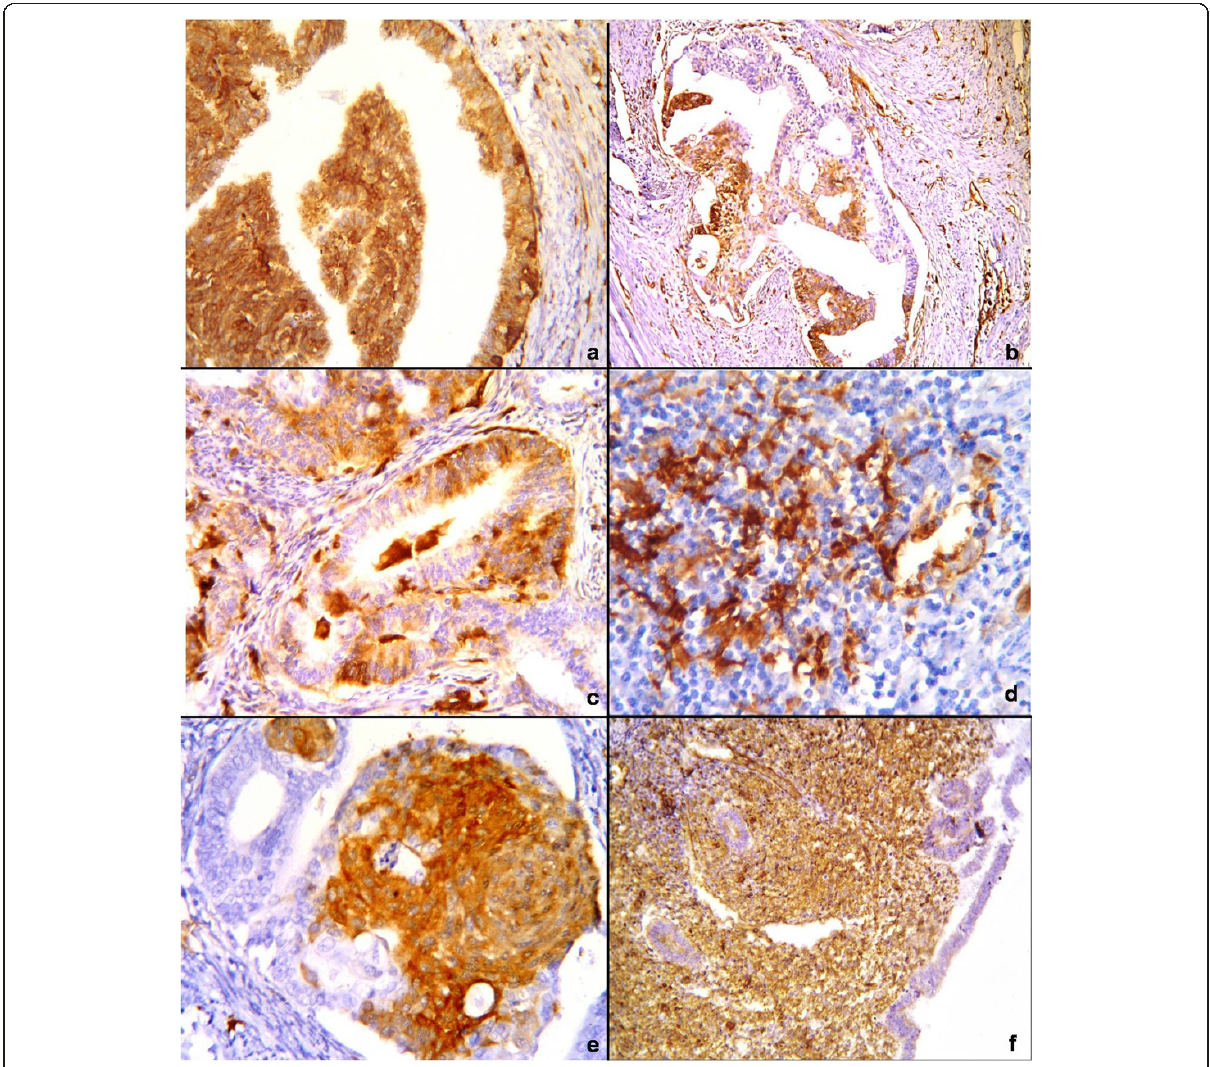
Figure 1 Immunohistochemical staining for fascin. ( a ) Strong fascin expression in tumour glands. ( b ) Heterogeneous expression was seen in the same gland. ( c ) Areas where immunoreactivity was seen at the peripheral portion of the glands. ( d ) The expression in an MELF-type area in a grade 2 tumour. ( e ) The expression in the areas of squamous differentation. ( f ) Diffuse staining of stroma in proliferative endometrium. B-SA peroxidase, DAB: [( a ) and ( c )]×200, [( b ), ( e ), and ( f )]×100, and ( d